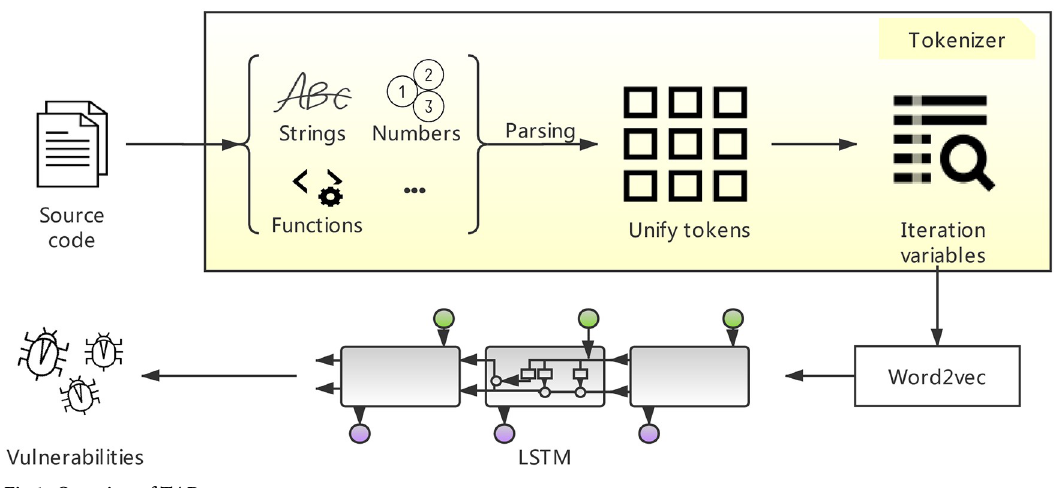
Fig 1. Overview of TAP.